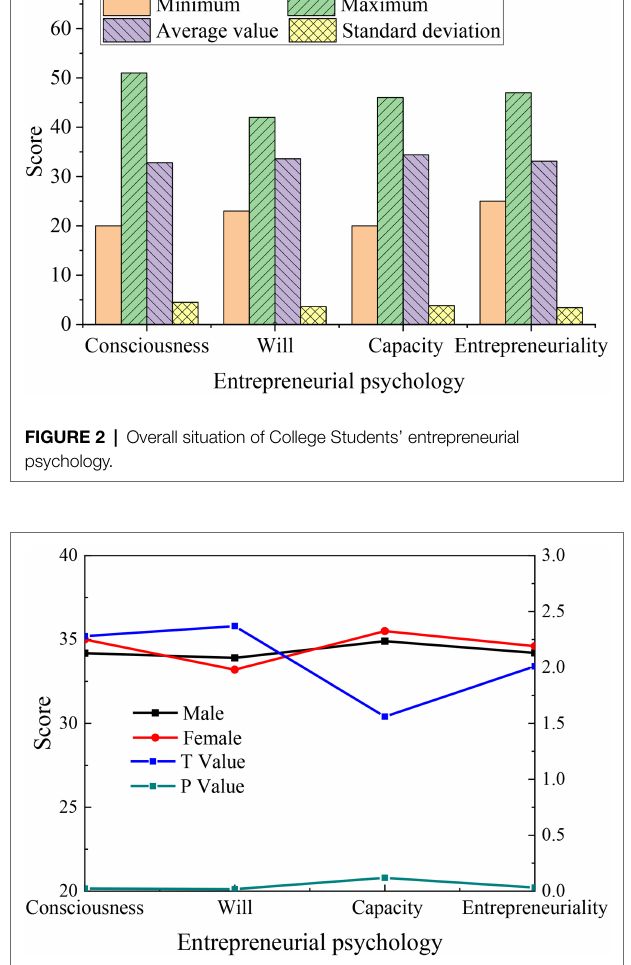
FIGURE 3 | Gender differences in entrepreneurial psychology of College